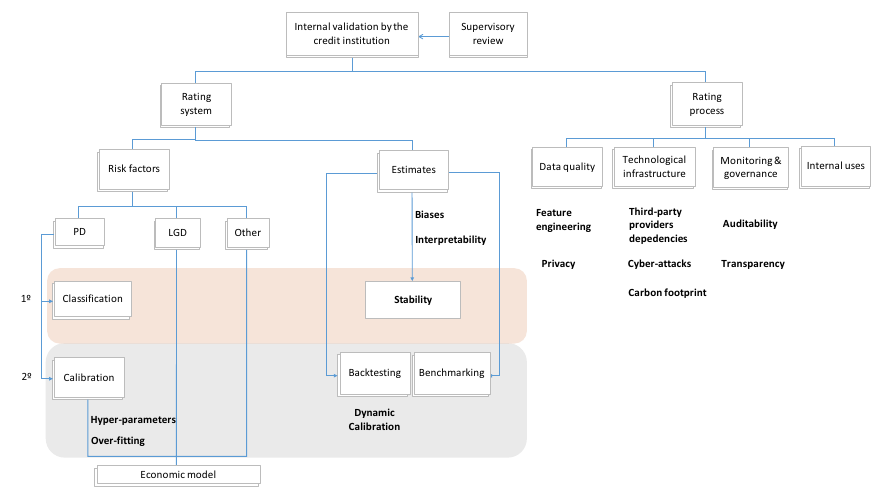
Fig. 2 Validation of IRB systems and its compatibility with